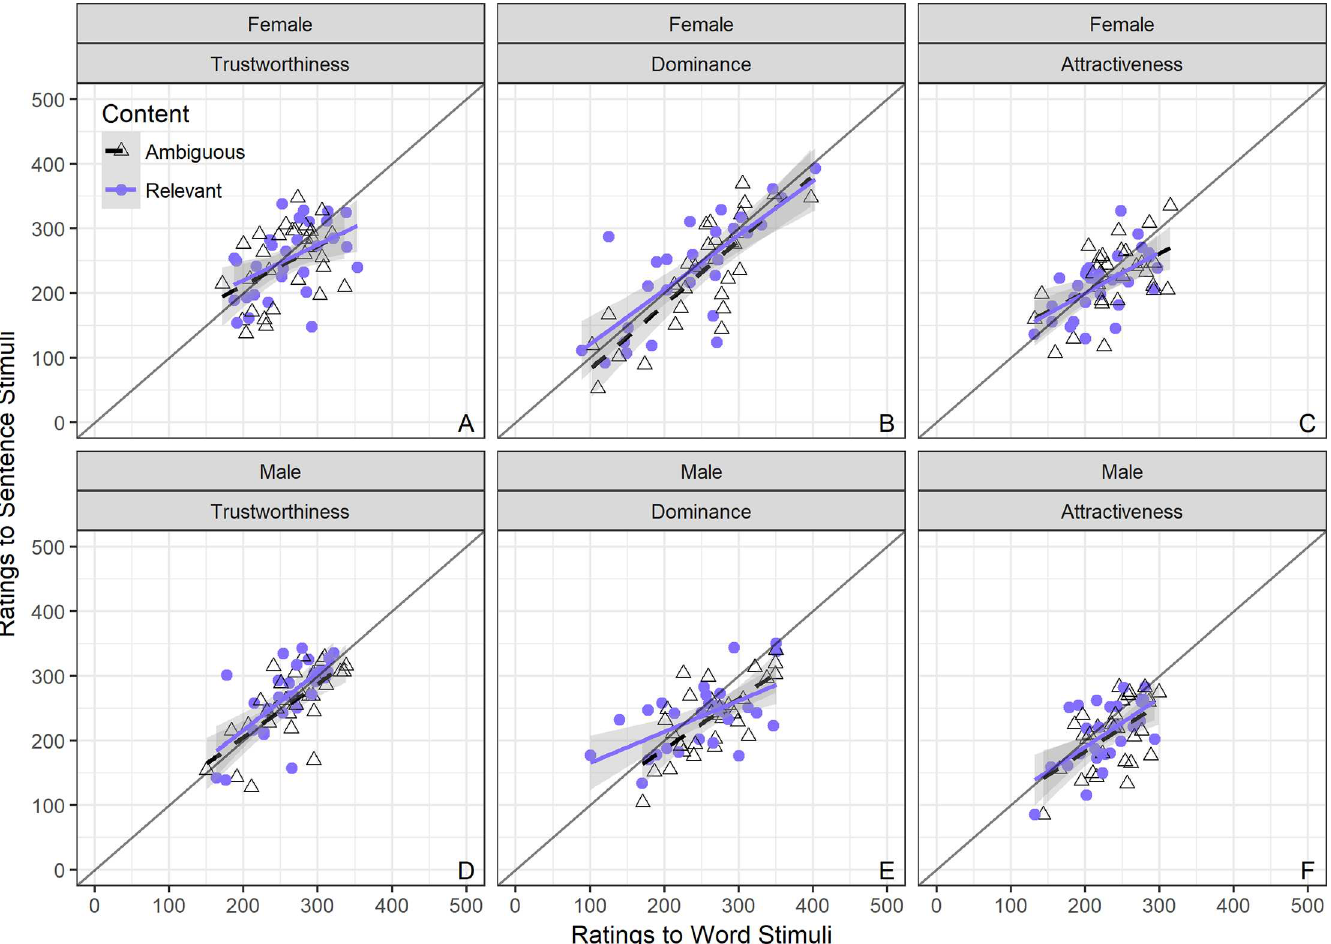
Fig 2. Scatterplots of VAS ratings for words versus sentences by content, in female (top) and male voices (bottom panels) for trustworthiness (left), dominance (middle), and attractiveness (right panel). Content-ambiguous (black dashed regression slope; open triangles represent individual voices) versus Content-relevant (blue solid regression slope; closed circles represent individual voices); grey line represents r =